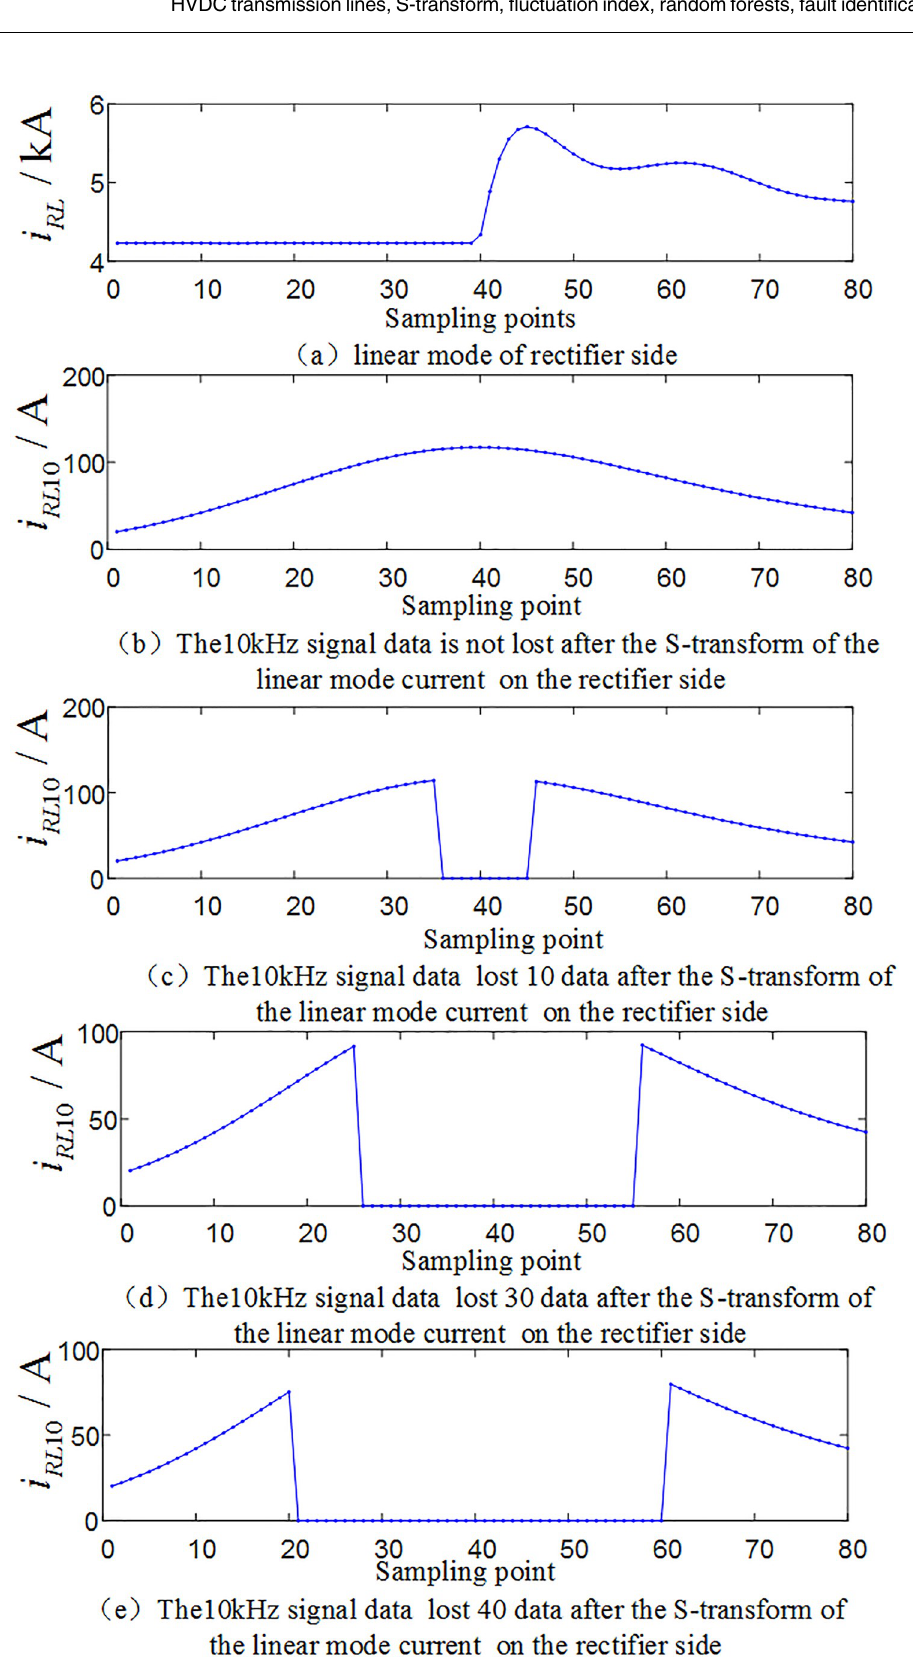
Fig 17. Correlation waveforms of data loss (10~40 data) near the traveling wave head. https://doi.org/10.1371/journal.pone.0230717.g017 PLOS ONE | https://doi.org/10.1371/journal.pone.0230717 March 26,